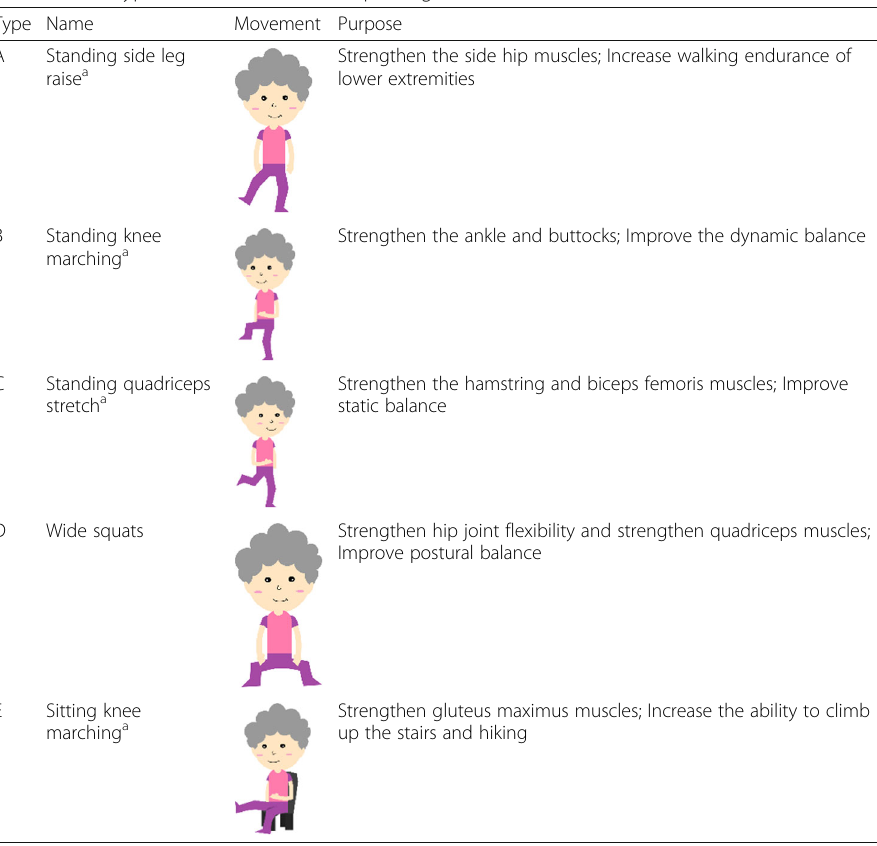
Table 1 Five types of movements for improving the elders ’ functional fitness Type